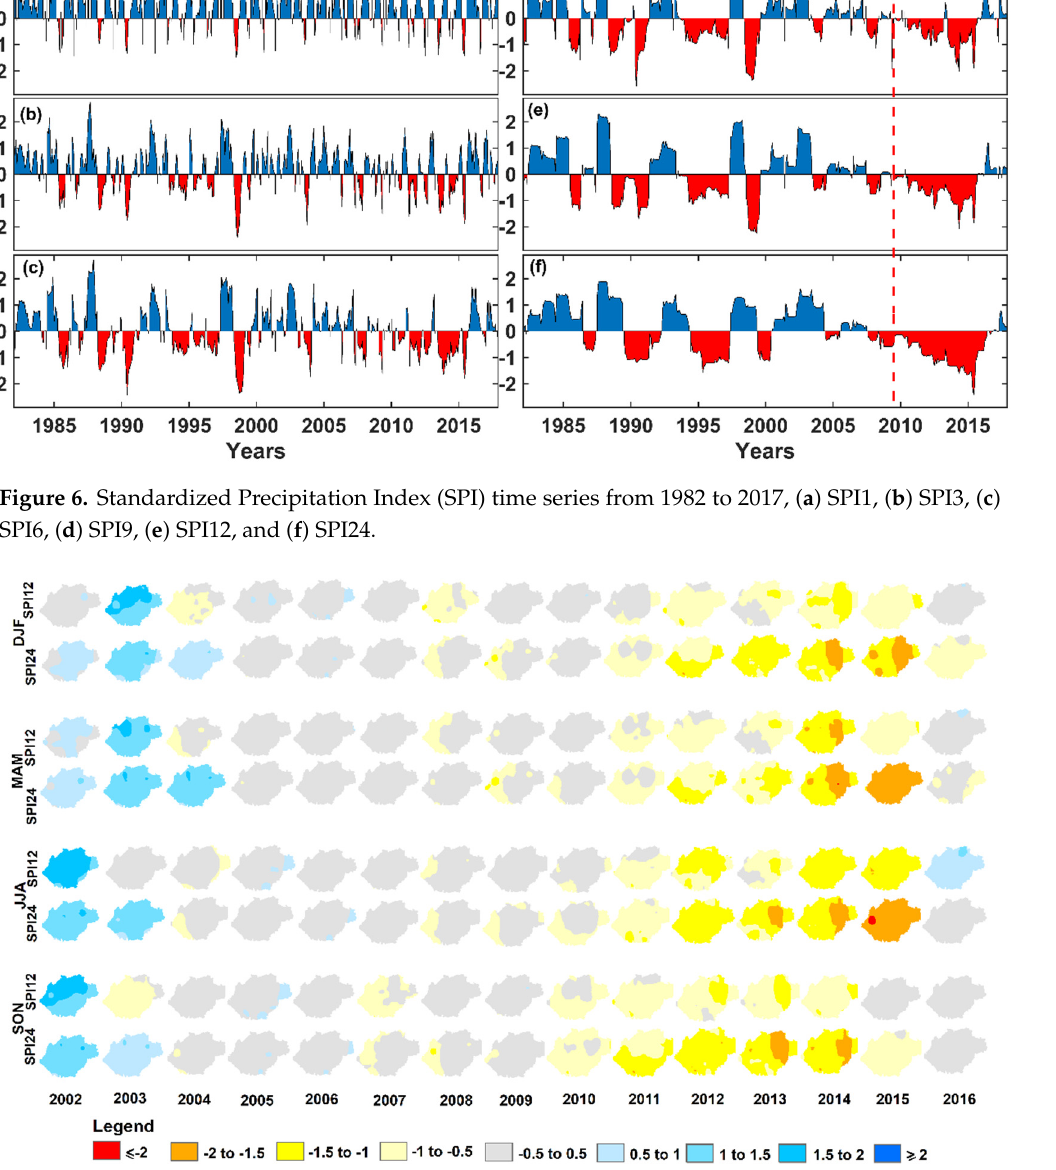
Figure 7. Spatial extent of SPI 12 and SPI 24 in the study area from 2002 to 2016 in summer (DJF), autumn (MAM), winter (JJA), and spring (SON).